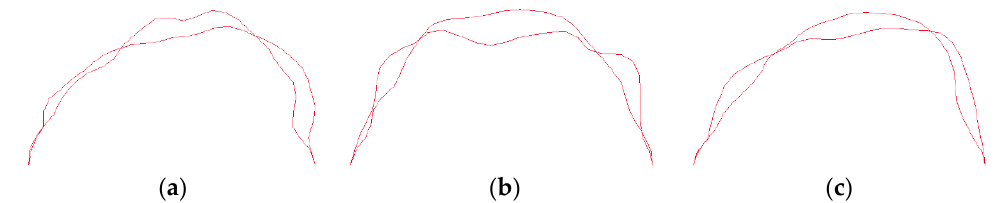
Figure 12. The displacement mode when t = 0.24 s, t = 0.60, t = 1.26 s, P21. ( a ) t = 0.24 s, ( b ) t = 0.60 s, and ( c ) t = 1.26 s.